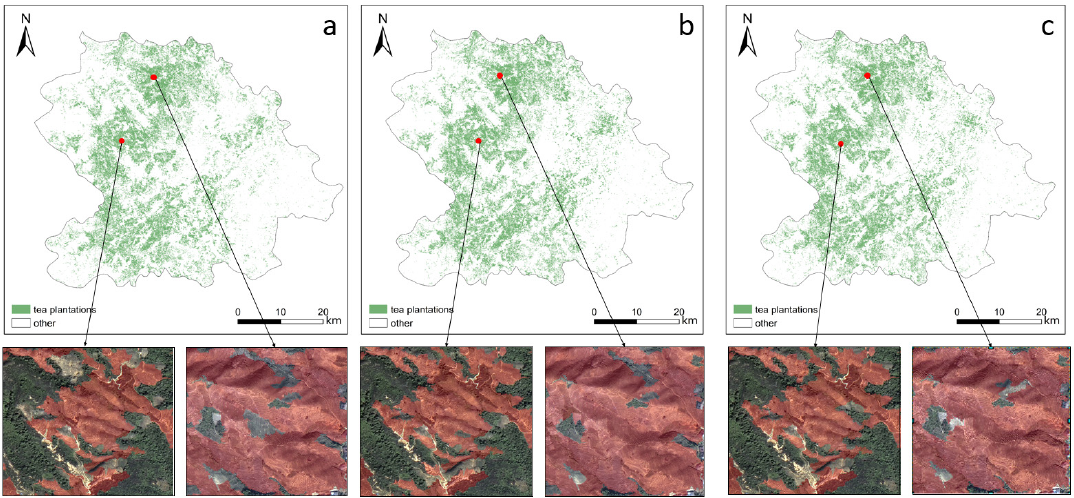
Figure 10. The final map of tea plantations in the study area: ( a ) Tea plantation results extracted by NO_FT; ( b ) tea plantation results extracted by FT_GF2; ( c ) tea plantation results extracted by FT_GE.